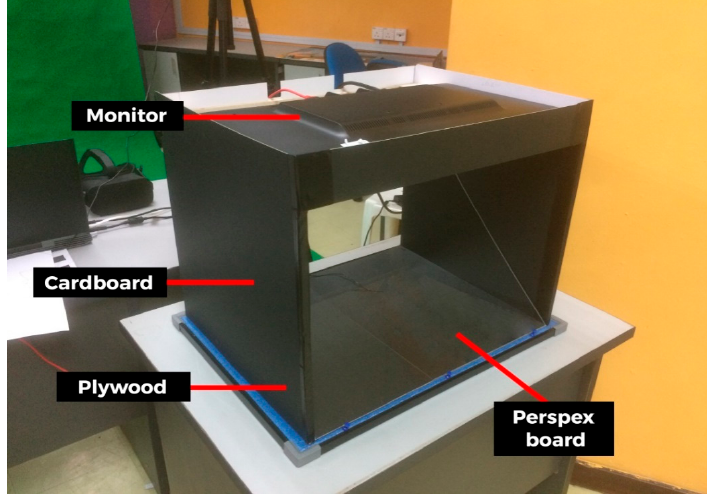
Figure 9. The Z-Hologram that was built for this